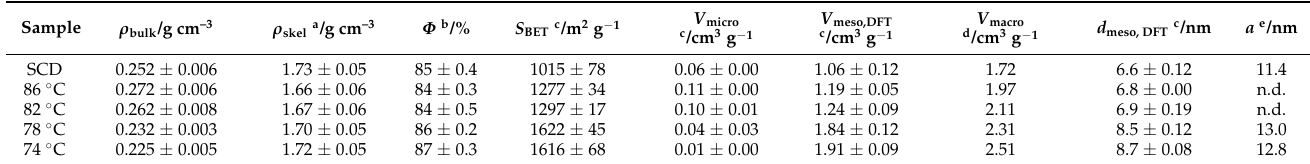
Table 1. Material and porosimetry characteristics of the silica samples after drying.